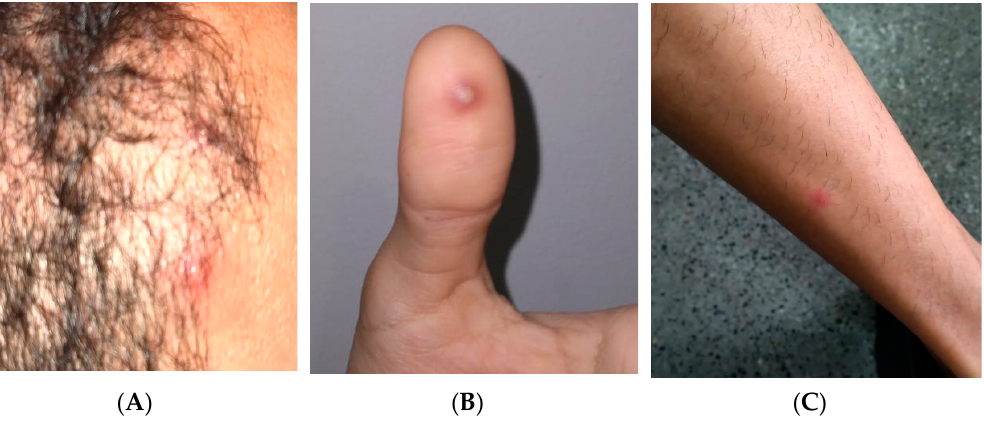
Figure 3. Lesions presented by case 2 at medical visit ( A – C ).